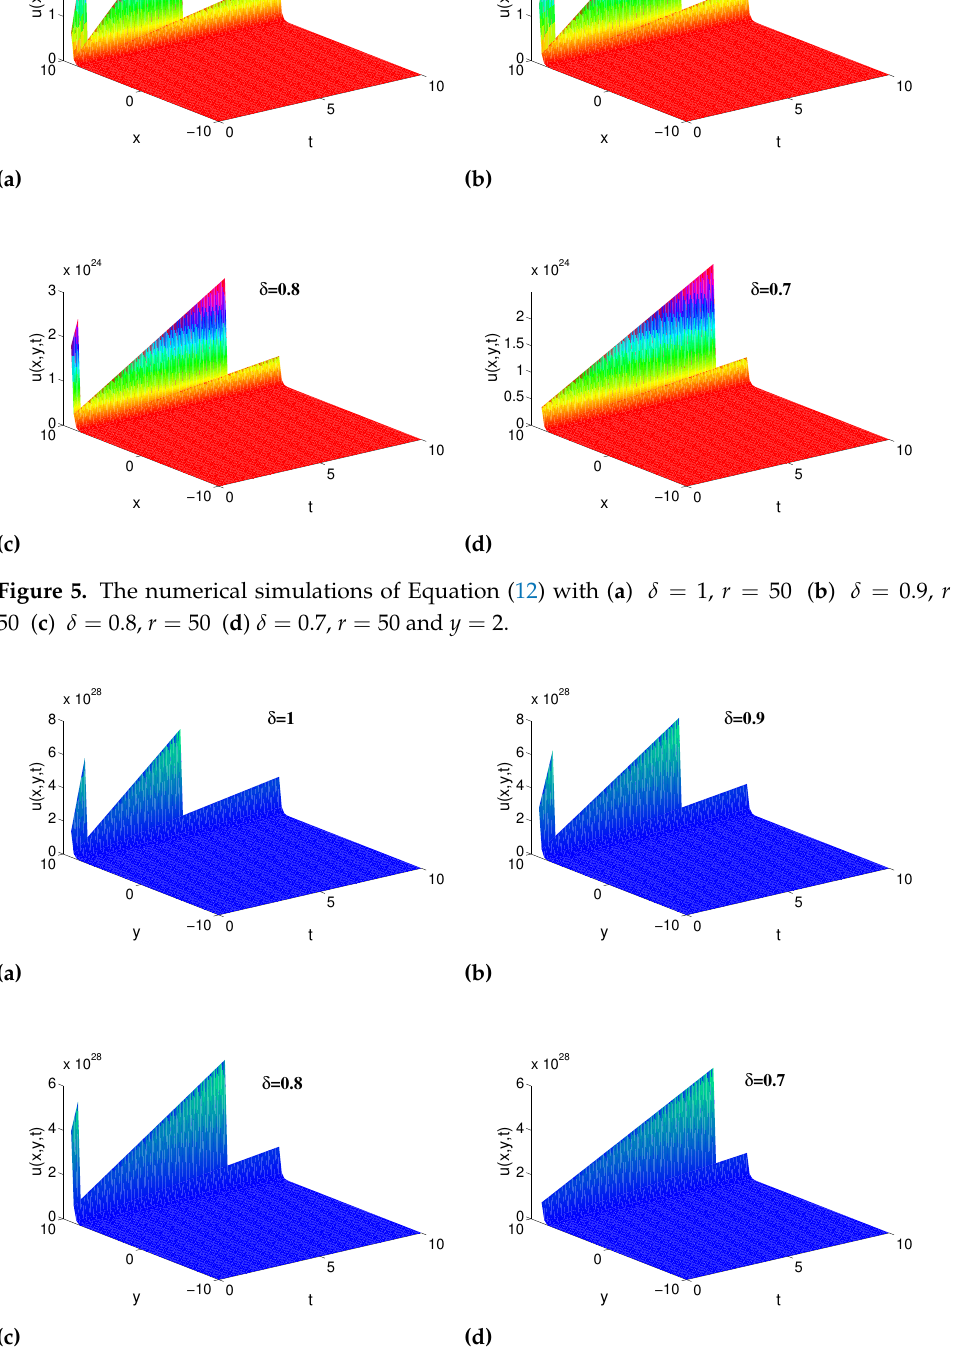
Figure 6. The numerical simulations of Equation (12) with ( a ) δ = 1, r = 50 ( b ) δ = 0.9, r = 50 ( c ) δ = 0.8, r = 50 ( d ) δ = 0.7, r = 50 and x =